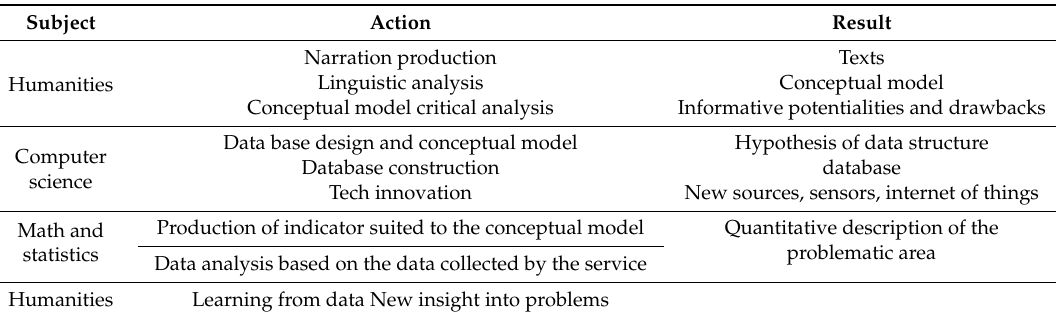
Table 2. Disciplinary contributions and their